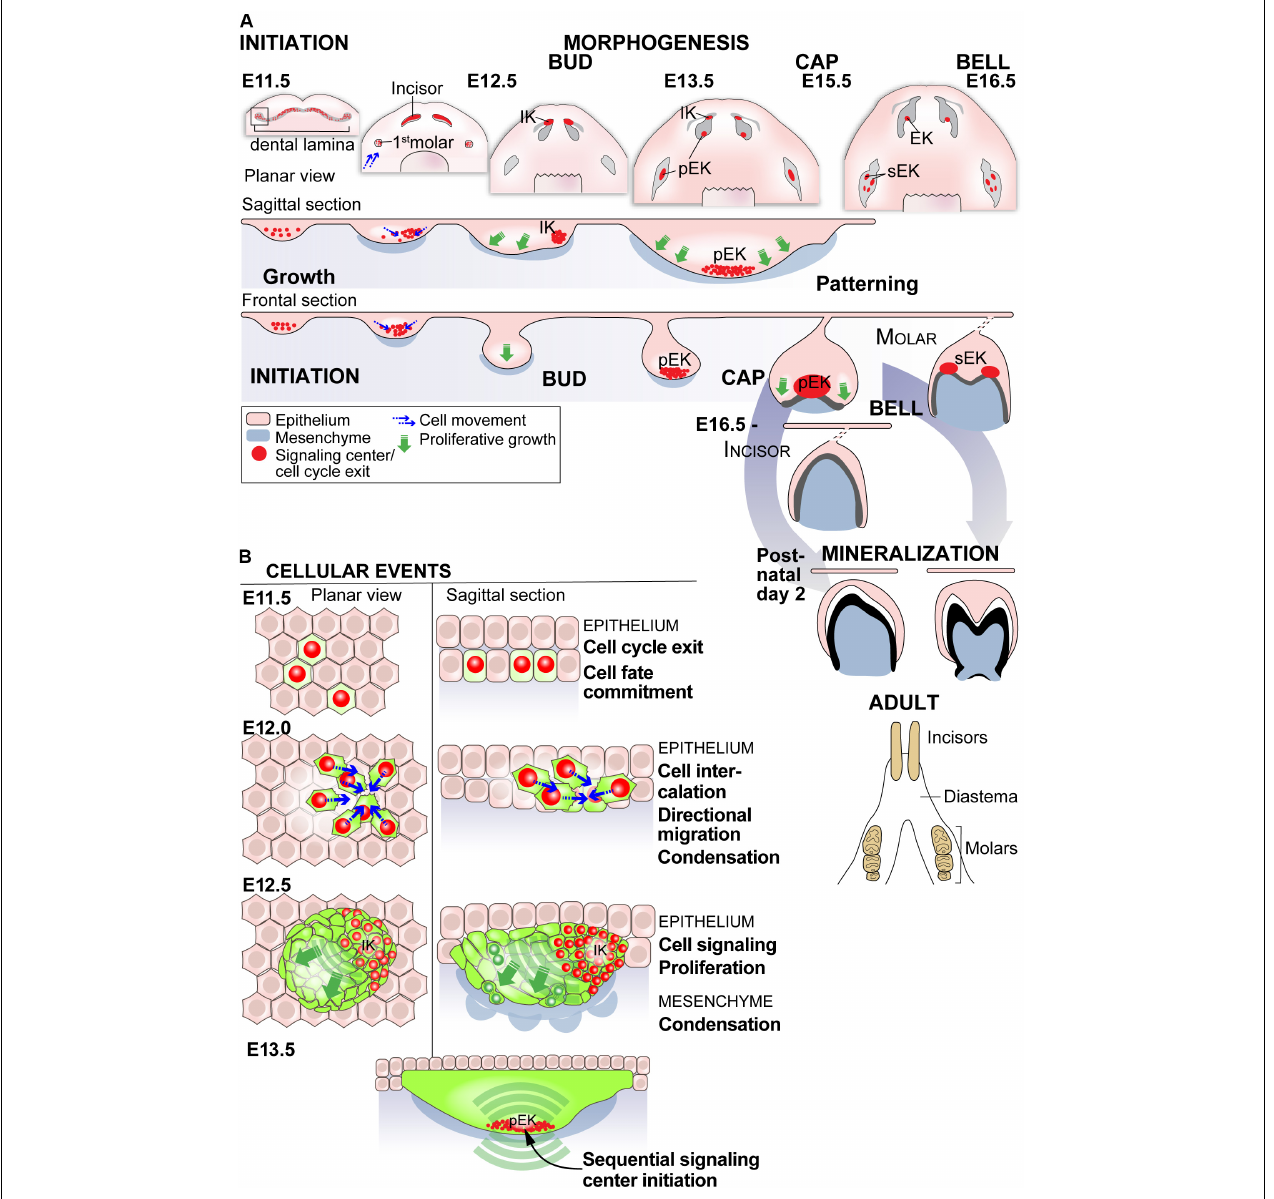
FIGURE 2 | Embryonic development of mouse teeth is governed by specialized signaling centers. (A) The embryonic development of mouse teeth in the lower jaw, the mandible, initiates at E11 with a continuous epithelial thickening called the dental lamina. In teeth the initial inductive signal is thought come from the epithelial compartment. The dental lamina resolves into separate placodes for the incisor and molar teeth. A group of cells in the placode acquire a signaling center fate, forming a specialized cluster of cells that signal to the neighboring cells to induce proliferative growth for budding (E12.5). This initiation knot (IK) signaling center is followed by successive signaling centers that use the same signaling pathways reiteratively. The first of these is called the primary enamel knot (pEK) that arises in the bud stage in both incisor and molar teeth. In the following cap stage the epithelium surrounding the signaling center extends deeper into the mesenchyme. Until the stage the development proceeds in a similar way in incisors and molars. The pEK is followed by secondary enamel knots (sEK), but only in the molar tooth, that regulate the epithelial folding into cusp patterns. The first molar is followed by two more molars developing sequentially posteriorly to the first one. In the mouse mandible the incisors and molars have a toothless diastema region in between. The teeth go through differentiation, hard tissue mineralization and erupt postnatally. The incisors continue to grow through the lifetime of the animal, whereas the molars do not grow after complete mineralization. (B) The cellular events driving tooth morphogenesis share features with the hair follicle, but there is also differences. The initial epithelial specification into placodes includes cell cycle exit and active cell condensation in both. In the hair follicle the whole placode seems to act as a signaling center, while in teeth a subpopulation of epithelial cells show the hallmarks of the signaling center behavioral signature including specific marker expression, cell cycle exit and active migration for condensation. The epithelial specification is accompanied by mesenchymal condensation also in teeth. The successive epithelial signaling centers, receiving inductive signals from the mesenchyme, shape the developing tooth by controlled ligand distribution driving specific proliferative growth patterns and are ultimately silenced by apoptosis (Jernvall and Thesleff, 2012; Prochazka et al., 2015; Ahtiainen et al., 2016; Morita et al., 2016; Panousopoulou and Green, 2016).